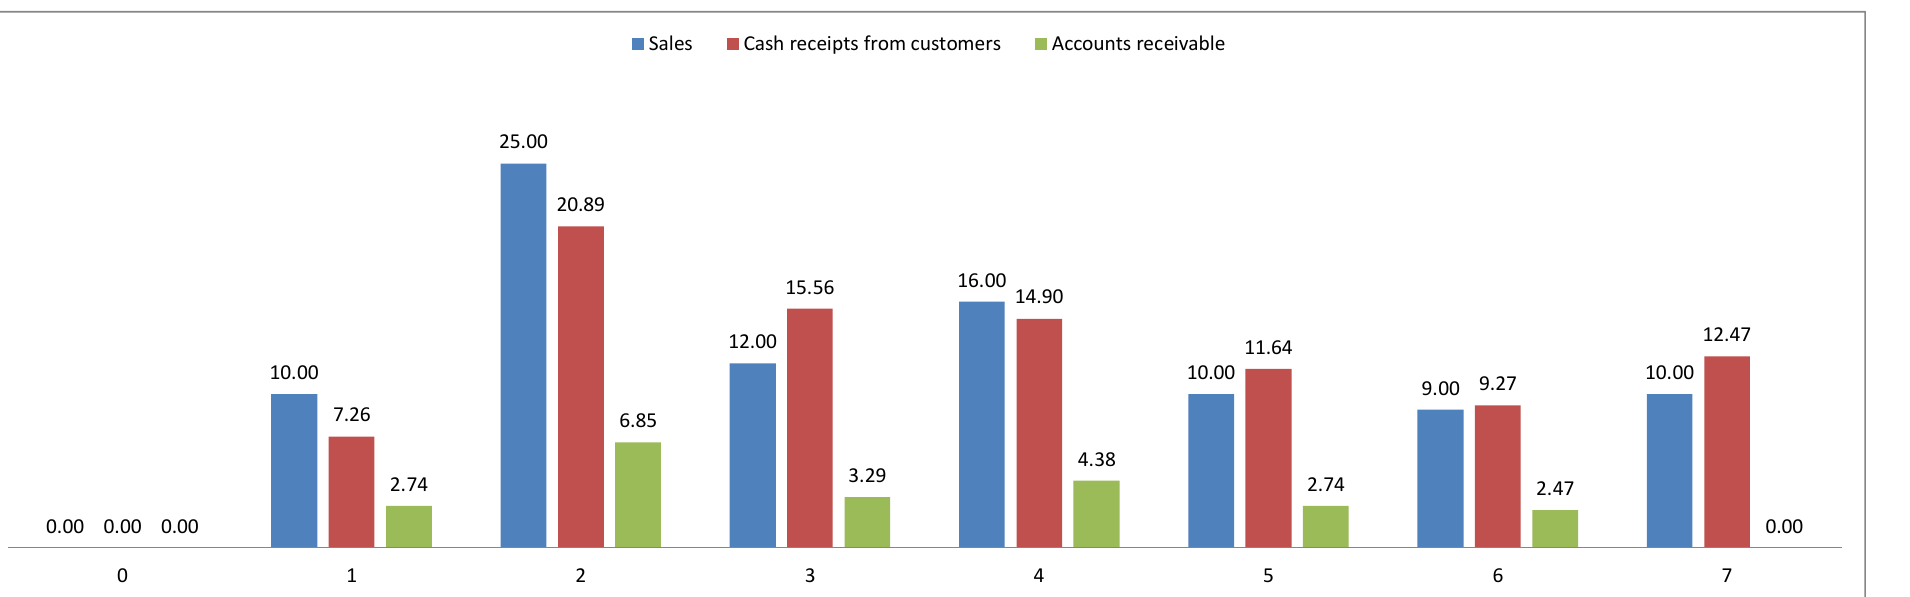
Figure 2. The law of motion for the AR of a firm which is incorporated at time t = 0 and terminates operations at time t = 7. Sales revenues are (0, $10, $25, $12, $16, $10, $9, $10). Assuming sales are uniformly distributed and trade credit is equal to 100 days, 72.6% (=265/365) of the sales are paid within the year, while the remaining 27.4% of the sales are paid in the next year (we assume, for the last year, that all sales are paid within the year). The cash flows from customers are ( 0, $7.26, $20.89, $15.56, $14.90, $11.64, $9.27, $12.47 ) and the AR are ( $74, $6.85, $3.29, $4.38, $2.74, $2.47, $0.00 ) . The height of every green bar is determined by the previous green bar (AR), increased by the height of the blue bar (sales) and decreased by the height of the brown bar (cash flows). Green bars at times 0 and 7 do not appear because AR 0 = AR 7 =